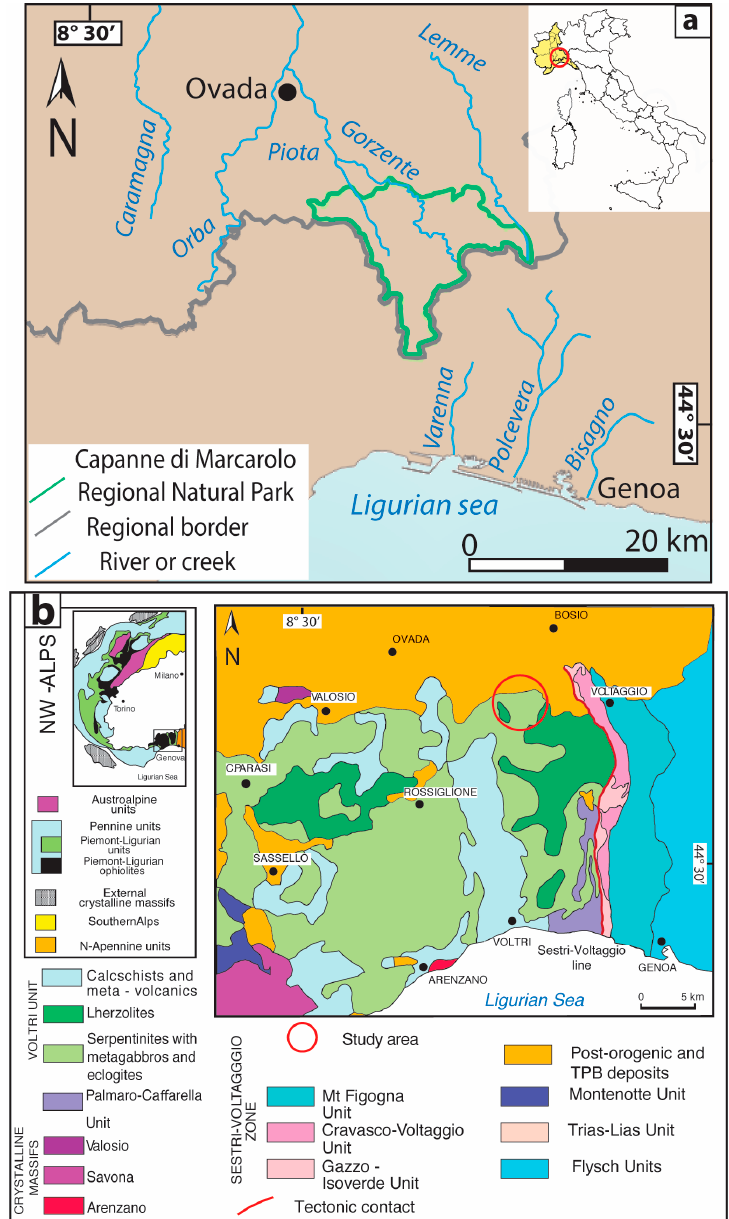
Figure 1. (Color online): ( a ) Geographical position of the study area; ( b ) Geological sketch map of the eastern Ligurian Alps and adjoining units, redrawn after Capponi and Crispini (2002); in the top left inset, a structural sketch map of the Western Alps is reported.